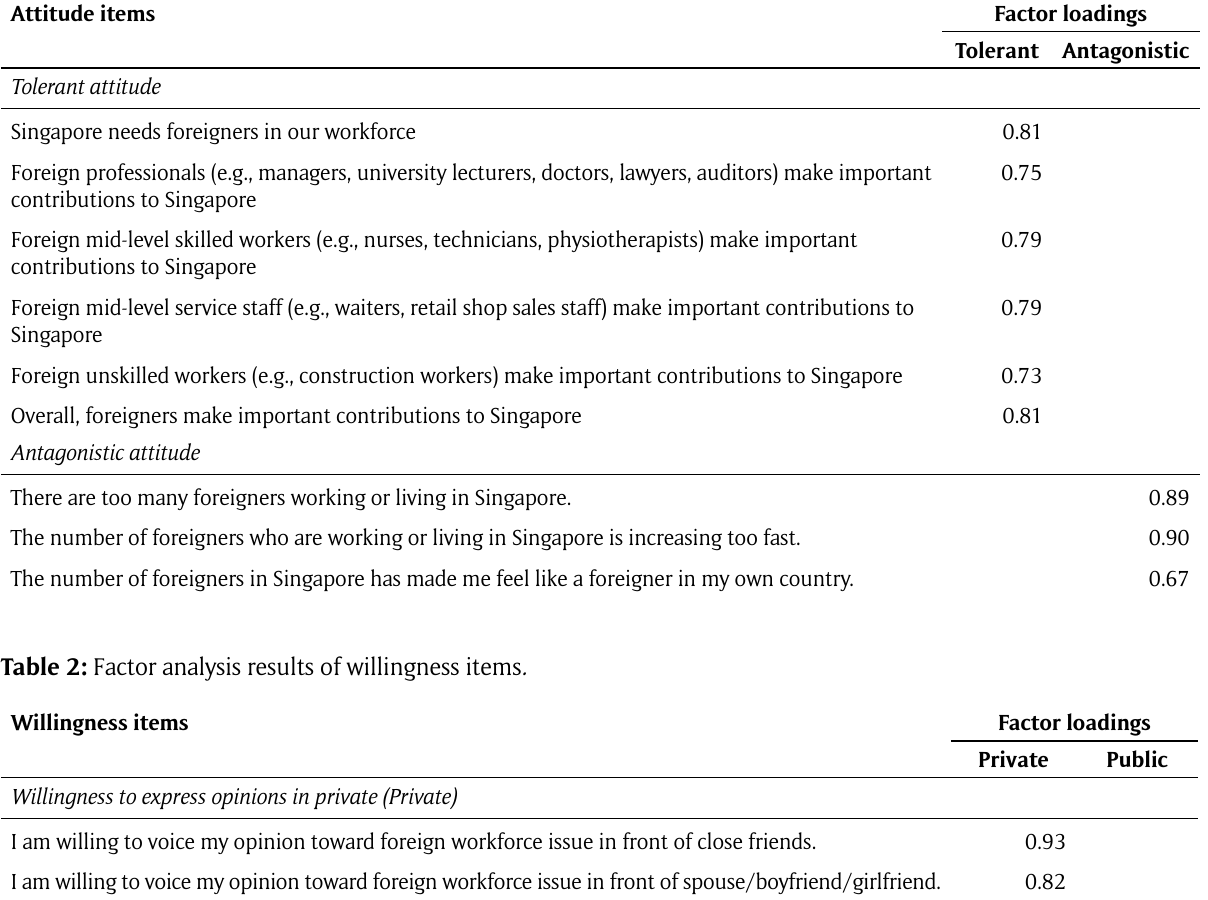
Table 1: Factor analysis results of attitude items.